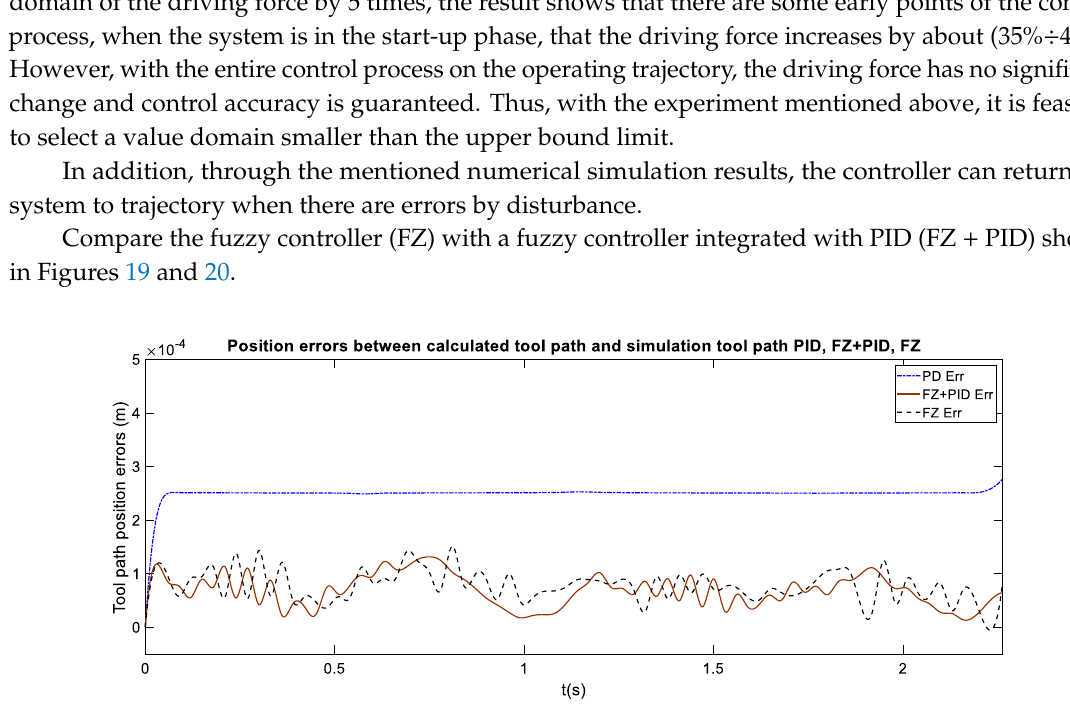
Figure 19. Tool path position errors between desired value and simulation result in normal cutting force mode.